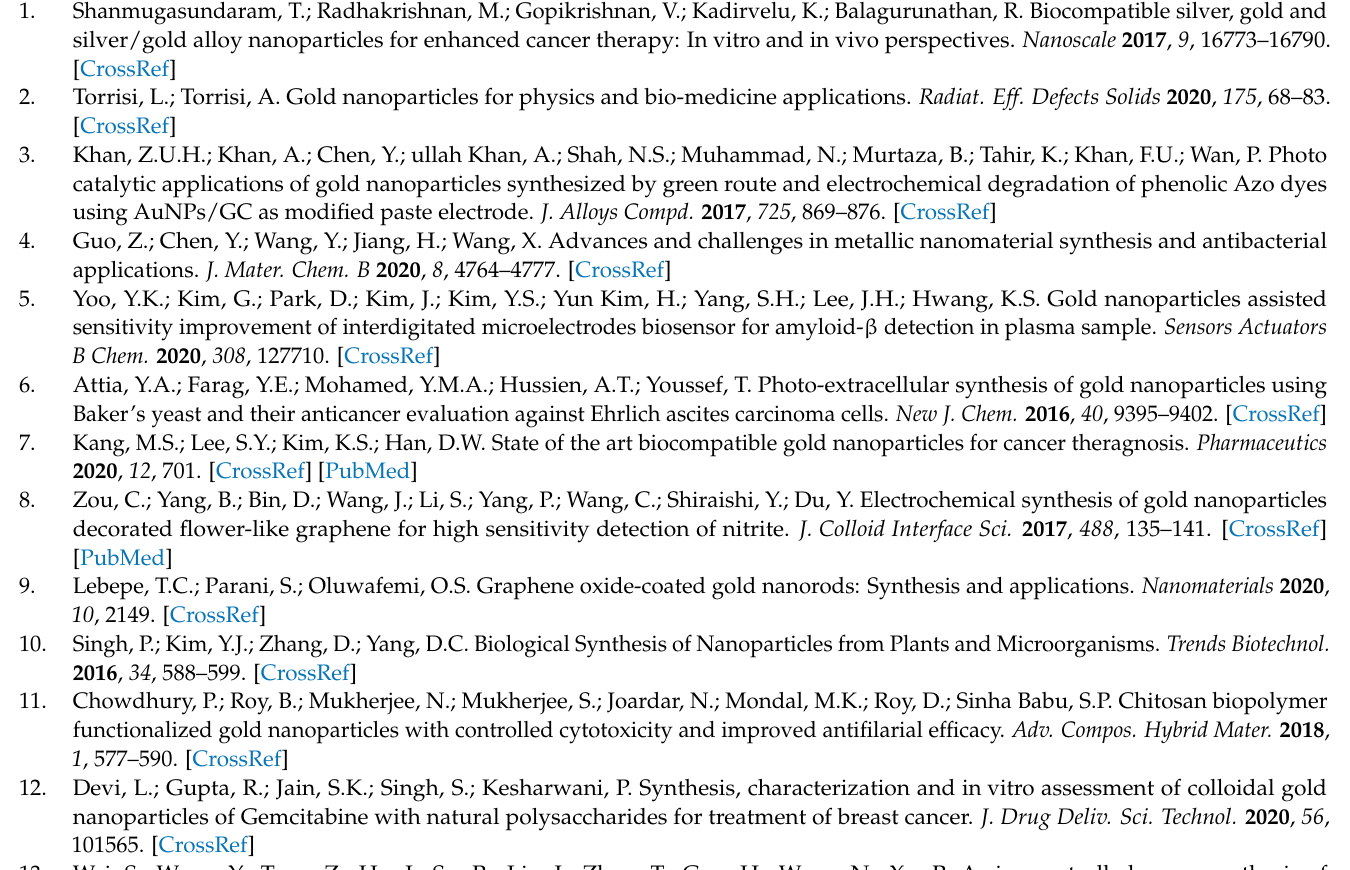
Table S4: DLS analysis of AuNPs after 60 days, Table S5: Antibacterial activity of AuNPs using 1 mL and 2 mL of CE by